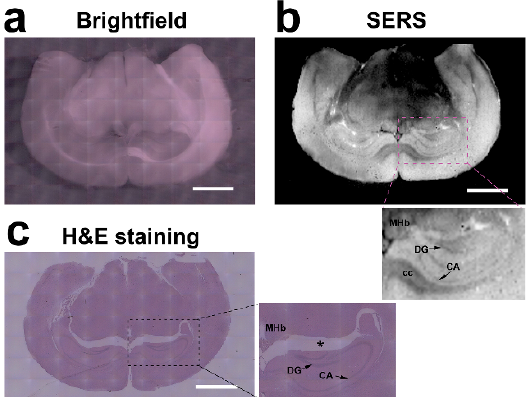
Figure 5. Accurate SERS texture analysis of brain tissue. ( a ) Brigthfield image; ( b ) SERS image induced by BP-AuNSs using the empty modelling approach. ( c ) Hematoxylin and eosin (H&E) staining of brain tissue section. Enlarged images showed the hippocampus (DG, dentate gyrus; CA, Ammon’s horn), medial habenular nucleus (MHb) and corpus callosum (cc) regions. The asterisk (*) showed the loss and displacement of tissue during section preparation process. Scale bar: 2 mm.